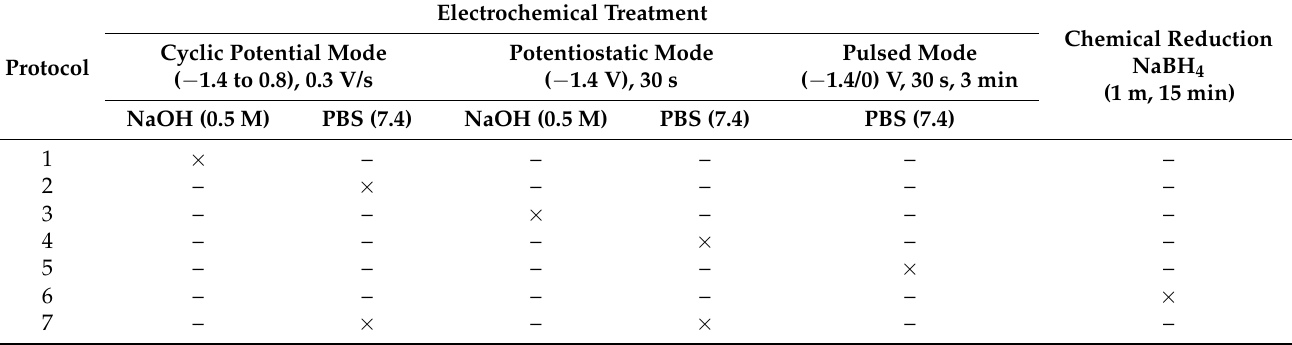
Table 1. Experiment planning matrix for choosing the method of the reductive pretreatment of gold electrodes at the last